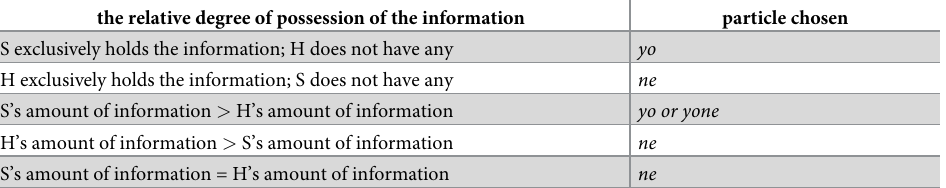
Table 6. The use of the negotiating particles ne and yo according to possession of information by speaker and hearer [54]. the relative degree of possession of the information particle